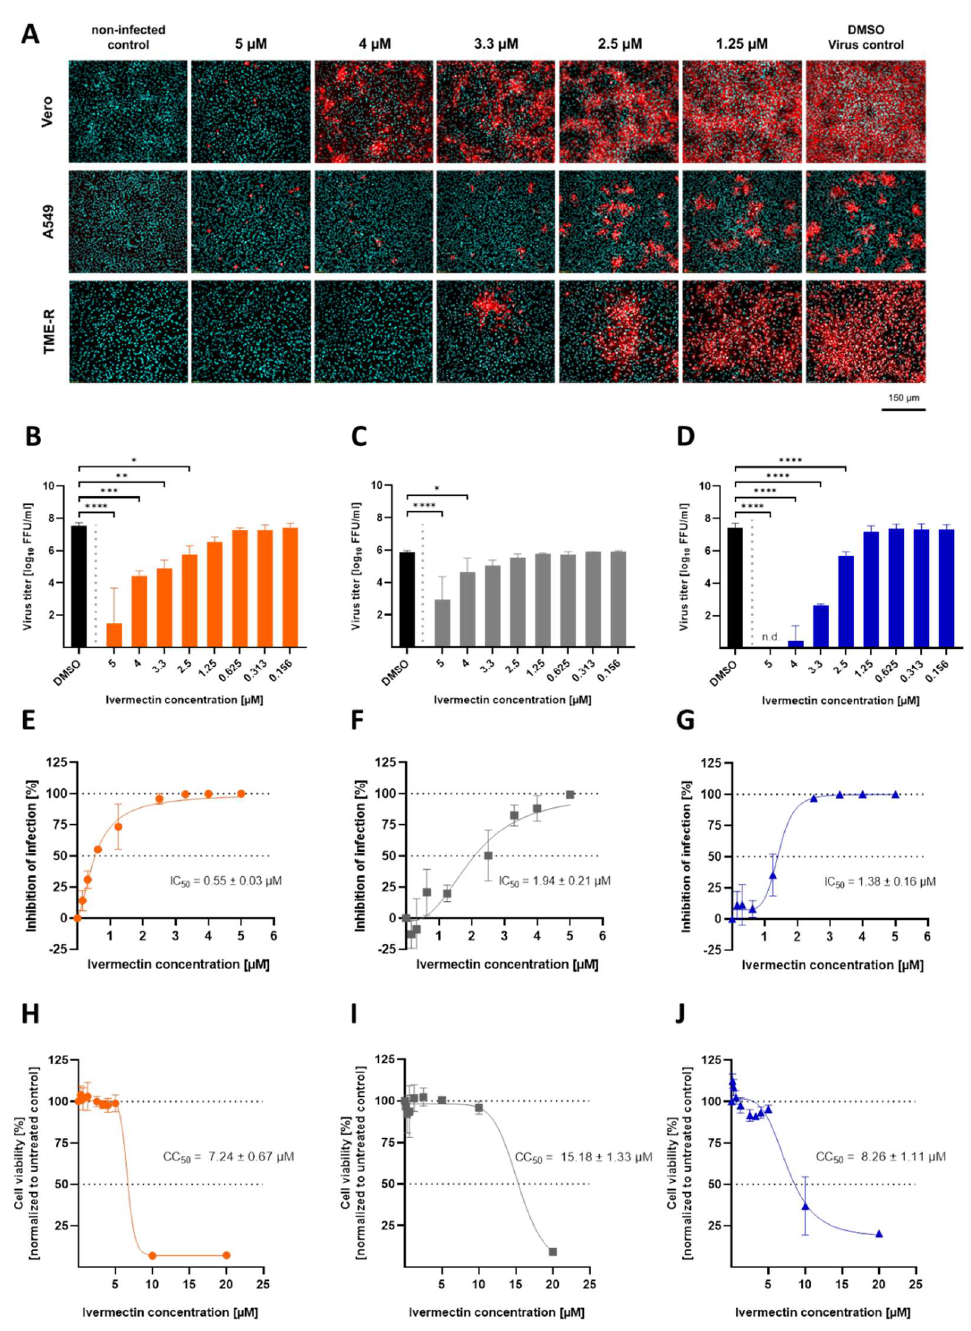
Figure 3. Antiviral efficacy of ivermectin against USUV in a concentration-dependent manner in several cell lines. Dose-dependent antiviral activity of ivermectin against USUV lineage Africa 3 at MOI of 0.1 was assessed in simian cell line Vero CCL-81, human cell line A549 and avian cell line TME-R. ( A ) Immunofluorescence staining of USUV-infected cells was performed in the presence of different ivermectin concentrations. Due to correlation between viral titer in the supernatant and percentage of infected cells, staining was done after 24 h in A549 and after 72 h in Vero CCL 81 and TME-R cells. Flavivirus antigen is depicted in red and cell nuclei stained with DAPI are shown in cyan blue. ( B – D ) Quantification of extracellular infectious USUV particles released from Vero CCL-81 ( B ), A549 ( C ) and TME-R ( D ) was evaluated by virus titration. ( E – G ) Half maximal inhibitory concentrations (IC 50 ) of ivermectin were calculated in Vero CCL-81 ( E ), A549 ( F ) and TME-R ( G ) cells. Inhibition of infection was calculated by titration of supernatants from untreated USUV control in comparison to ivermectin treated panels. Data represent mean values ± SD from independent